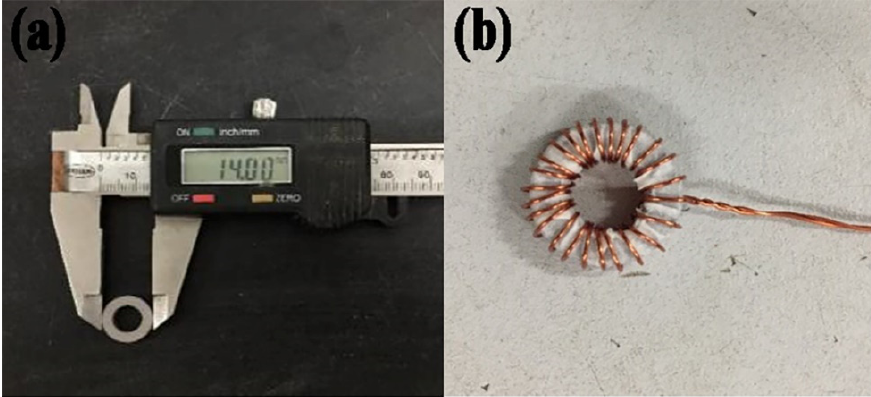
Figure 2. The SMCs sample to be tested: ( a ) magnetic powder core size and ( b ) coil winding before magnetic performance test.